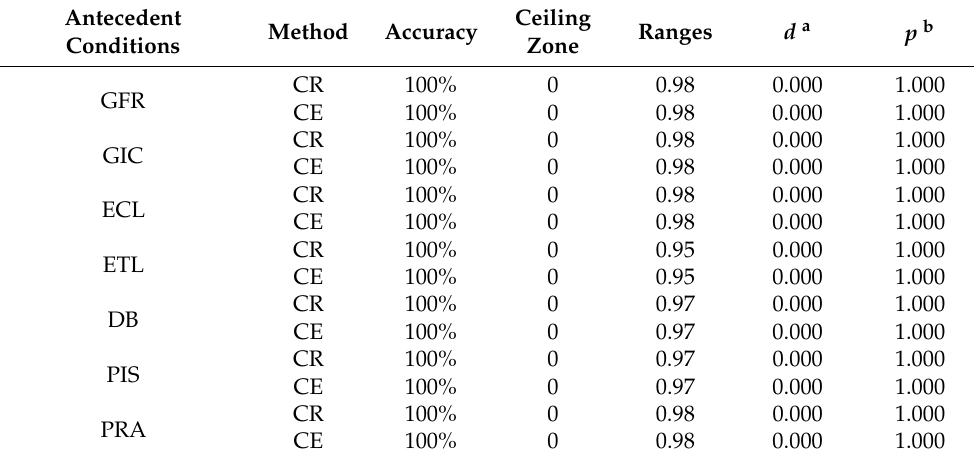
Table 2. Results of the NCA method for determining necessary